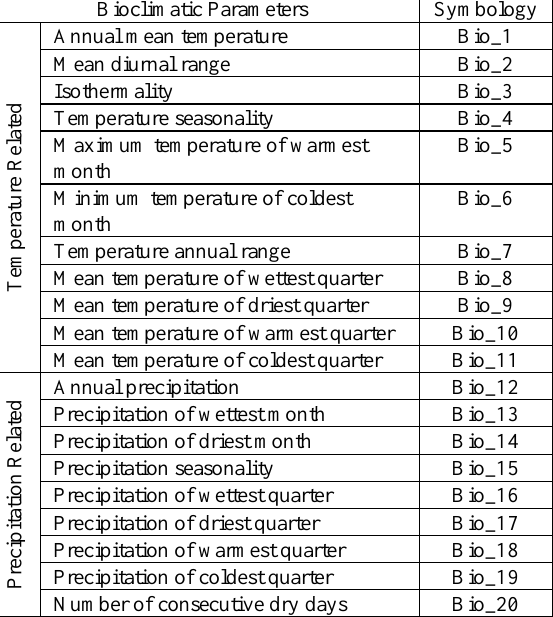
Table 1. Bioclimatic variables used in crop distribution